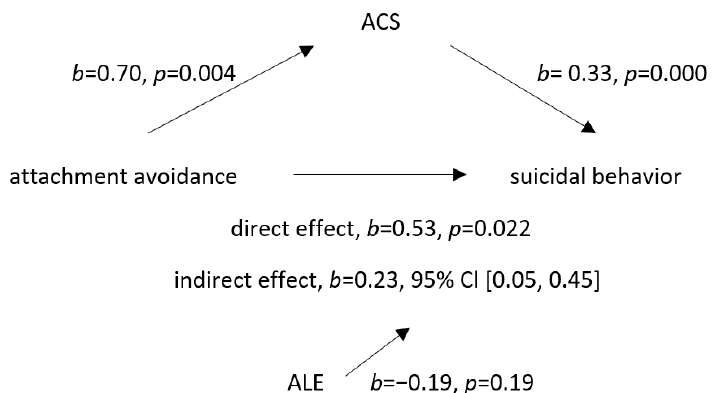
Figure 1. Mediation model with acquired capability for suicide (ACS) as the mediator of the association between attachment avoidance to mother and suicidal behavior. Adverse life experiences were included as a covariant. Legend : ACS—acquired capability for suicide, ALE— adverse life experiences, direct effect—association between attachment avoidance and suicidal behavior, and indirect effect—association between attachment avoidance and suicidal behavior when ACS was added as the mediating variable.